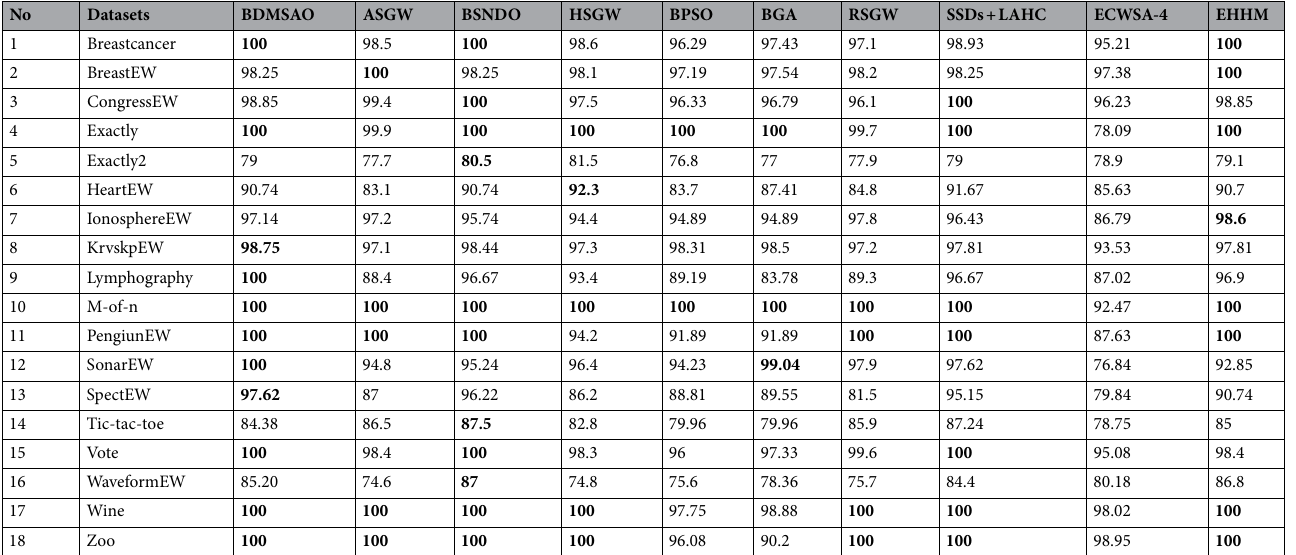
Table 5. Classification accuracy of BDMSAO in comparison with other well-known feature selection methods tested using the UCI dataset, and the highlighted results indicate the highest classification